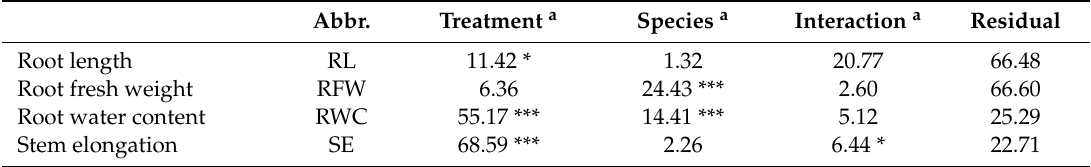
Table 1. Two-way analysis of variance (ANOVA) of species, treatment, and their interactions, for the indicated parameters. Numbers shown represent percentages of the sum of squares (SS).